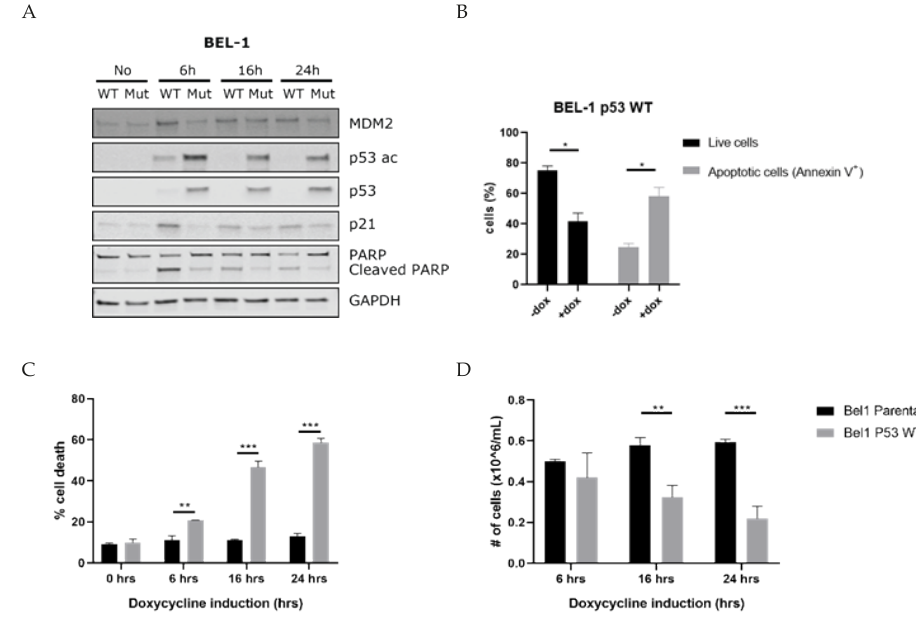
Figure 4. Forced p53 activation induces apoptosis in BEL-1 cells carrying wild-type p53 : ( A ) western blot analysis showing the protein expression of MDM2, p53 acetylation at lysine 382, p53, p21, and cleaved PARP measured at 6, 16, and 24 h post doxycycline induction in the transduced BEL-1 cell line carrying doxycycline-inducible expression vectors either encoding wild-type or mutated (R248Q) p53 . Housekeeping gene GAPDH was used as loading control. ( B ) Percentage of viable and apoptotic cells in BEL-1 cells carrying no vector (parental) or wild-type p53 , at 24 h post p53 induction by doxycycline determined by flow cytometric analysis of the Annexin V/7AAD staining. ( C ) Percentage of dead cells and ( D ) percentage of viable cells, measured by a manual cell count of Trypan Blue positive cells BEL-1 cells and Trypan Blue negative BEL-1 cells carrying either no vector (parental) or wild-type p53 , measured at 6, 16 and 24 h post p53 induction by doxycycline. All data points are represented as the mean ± SEM of n = 3. Cell viability comparisons between KMT2A -rearranged ALL cell line conditions were performed using the multiple t -test of average; * = p ≤ 0.05; ** = p ≤ 0.01; *** = p ≤